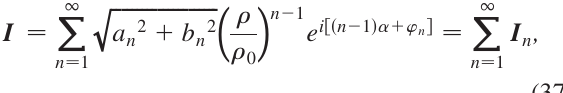
and 0 (left), (cid:2) 0